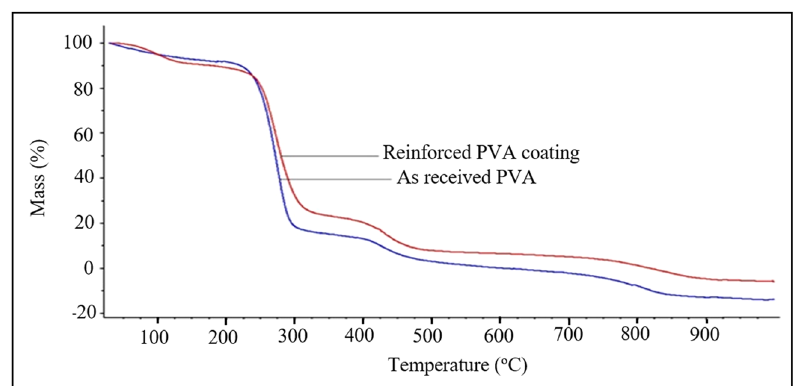
Figure 8: TGA of as - received PVA and reinforced PVA coating thermograms.